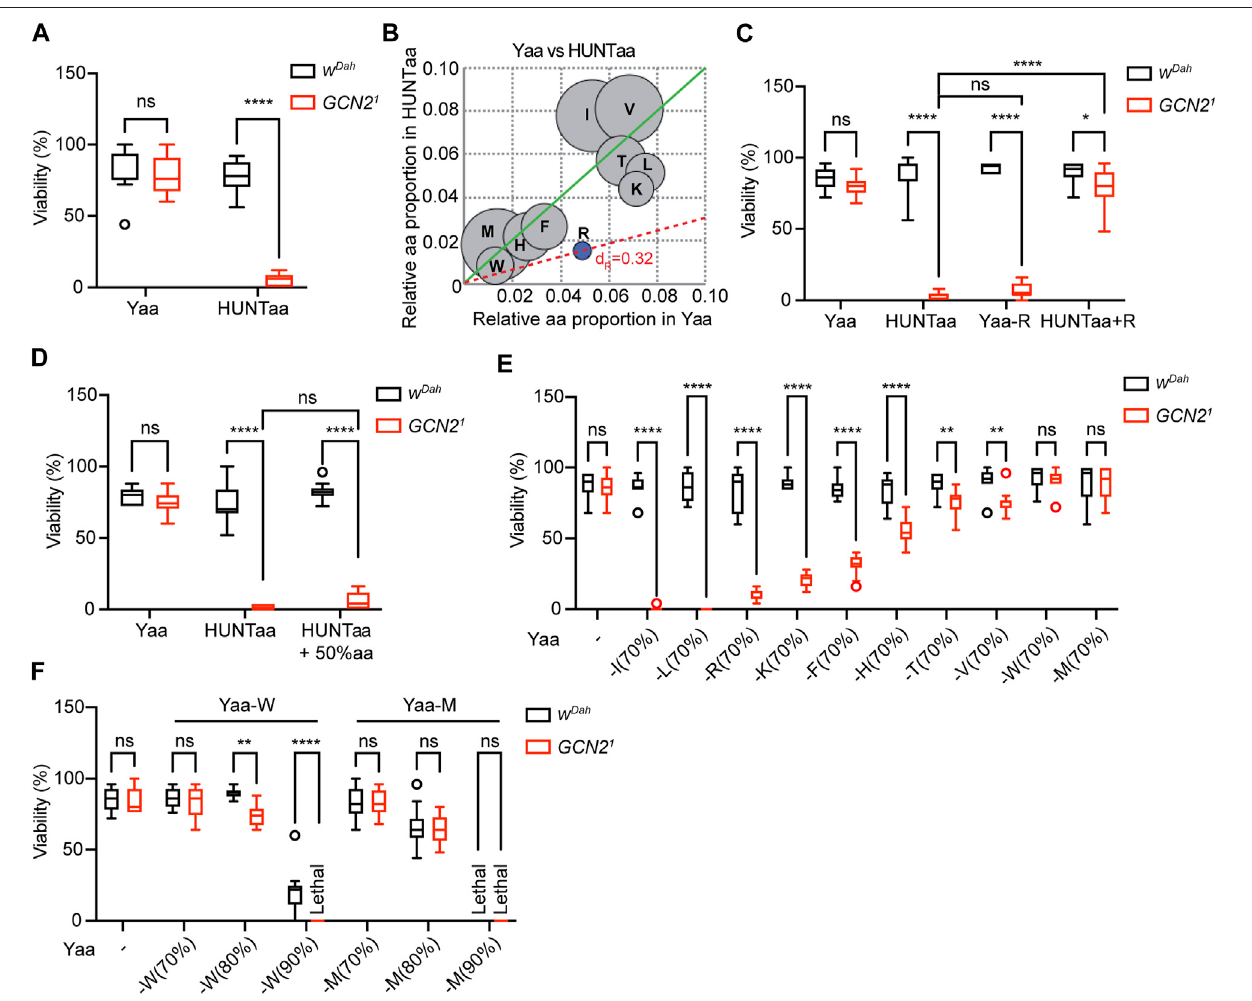
FIGURE 1 | GCN2 function is essential for development under restriction of individual EAA except for methionine. (A) Egg-to-adult viability of w Dah control and Gcn2 1 mutantsonchemicallyde fi nedYaaandHUNTaadiets. (B) RelativeproportionofEAAintheYaadietcomparedtotheHUNTaadiet.Arginine(R)highlightedinblue was identi fi ed as the most limiting EAA in HUNTaa. (C) Decreasing R in the Yaa diet by 70% ( − R) reduced viability of Gcn2 1 mutants. Supplementation of R to the HUNTaa (+R) dietrescued viability of Gcn2 1 mutants. (D) Increasing theabsoluteamount ofall aa by50% in HUNTaa did not rescue viability of Gcn2 1 mutants. (E) Viabilityof w Dah controland Gcn2 1 mutantsonYaadietswithindividualEAArestrictionby70%. (F) Viabilityof fl iesuponrestrictionofWandMby80%and90%.Viability (%) represents the percentage of eclosed adult fl ies per fl y embryo. n = 10 vials with 25 embryos per vial. Median, 25th and75th percentiles, and Tukey whiskers are indicated. Two-way ANOVA followed by Bonferroni ’ s post-hoc test, p values were adjusted for multiple comparisons.